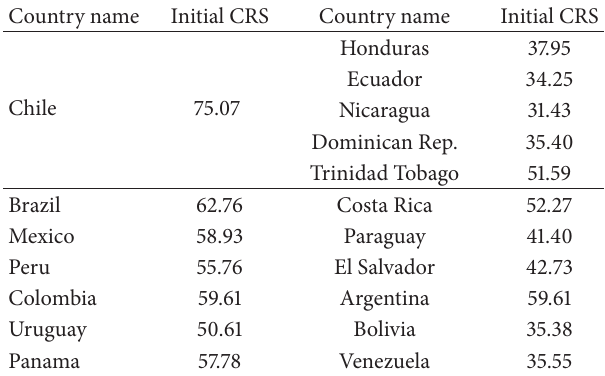
Table 2: Initial CRS data corresponding to February 6, 2012 (Euromoney, 2012